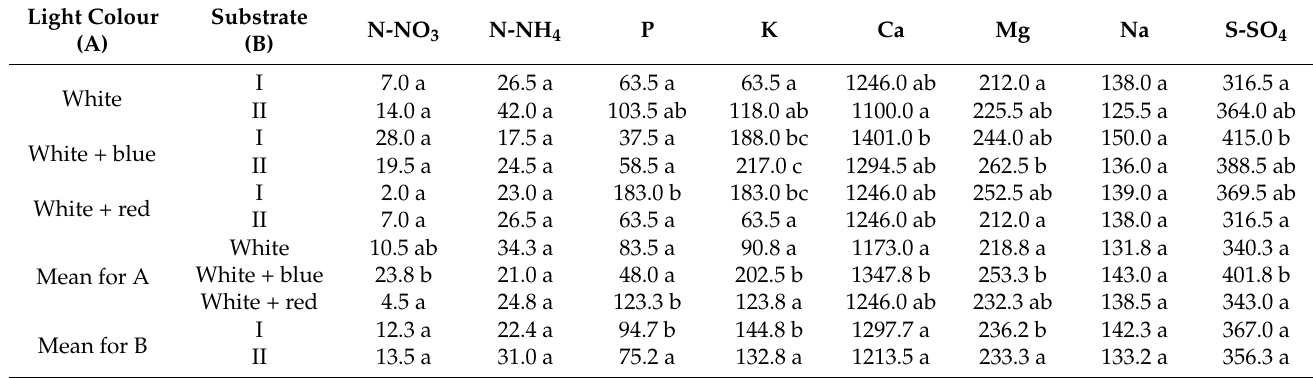
Table 1. Macronutrients and sodium content in substrate depending on light colour and substrate (mg · dm − 3